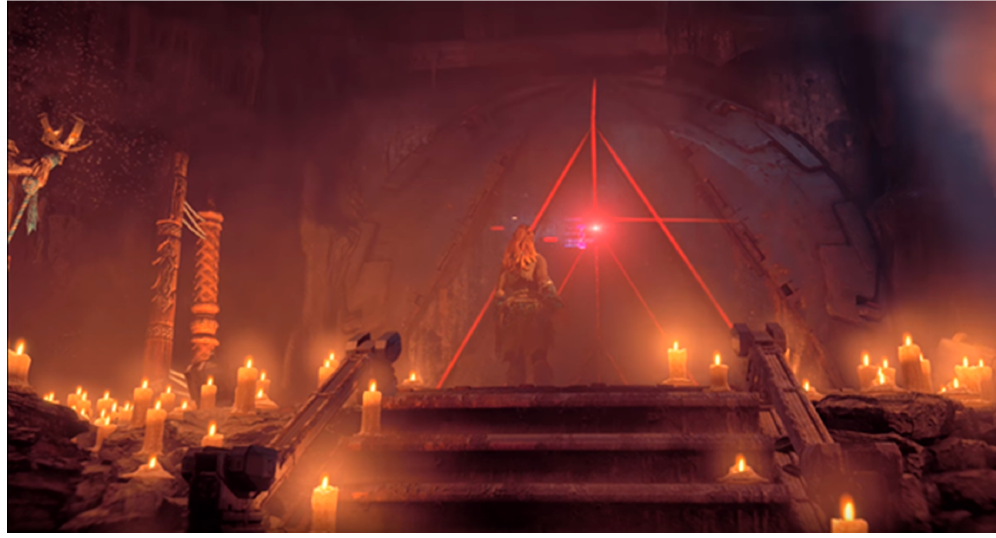
Figure 9. Aloy in front of an activated “All-Mother” – a glorified, but artificially intelligent door lock. Both the All-Mother and HADES, then, are confused for wise, utopian agents, even though their goals are clear and their algorithms do not encompass more than that. HADES is the “extinction failsafe protocol” for GAIA, the head AI charged with repopulation; the All-Mother is the Nora’s name for GAIA’s digital door-guard. Machines and extremely intelligent AI have thus become so incomprehensible for 31st-century humans that they are considered to be gods and goddesses and are worshipped with utter devotion.